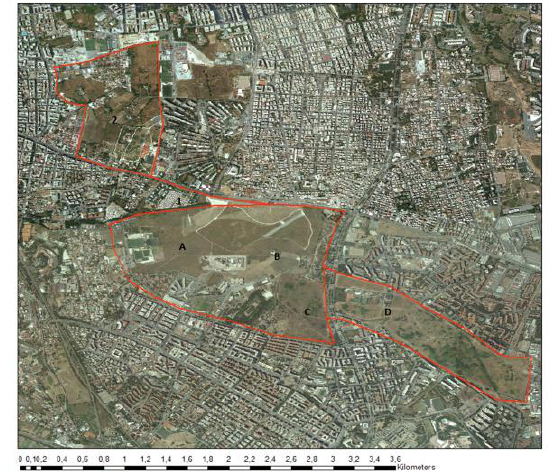
Figure 2. Map of the location of ancient quarries and settlements: A) Villa della Piscina, B) Villa Ad Duas Lauros, C) Villa delle Terme and 1) subterranean quarry (Centocelle Park); D) Villa Repubblicana (Striscia di Torrespaccata);